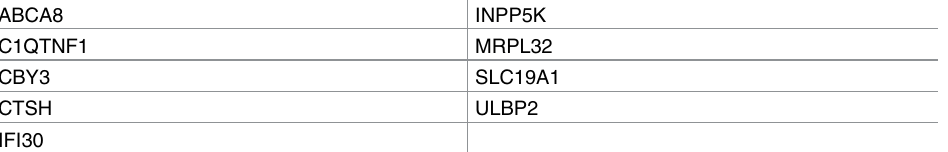
Table 4. Brain perivascularproteins curated from the Human Protein Atlas. Proteinsto be expressedin brain perivascular cells but excludedfrom EC and SMC are listed (n = 9). Proteinsin perivascular compart- ments but also in other vascular cell types are listed in Tables